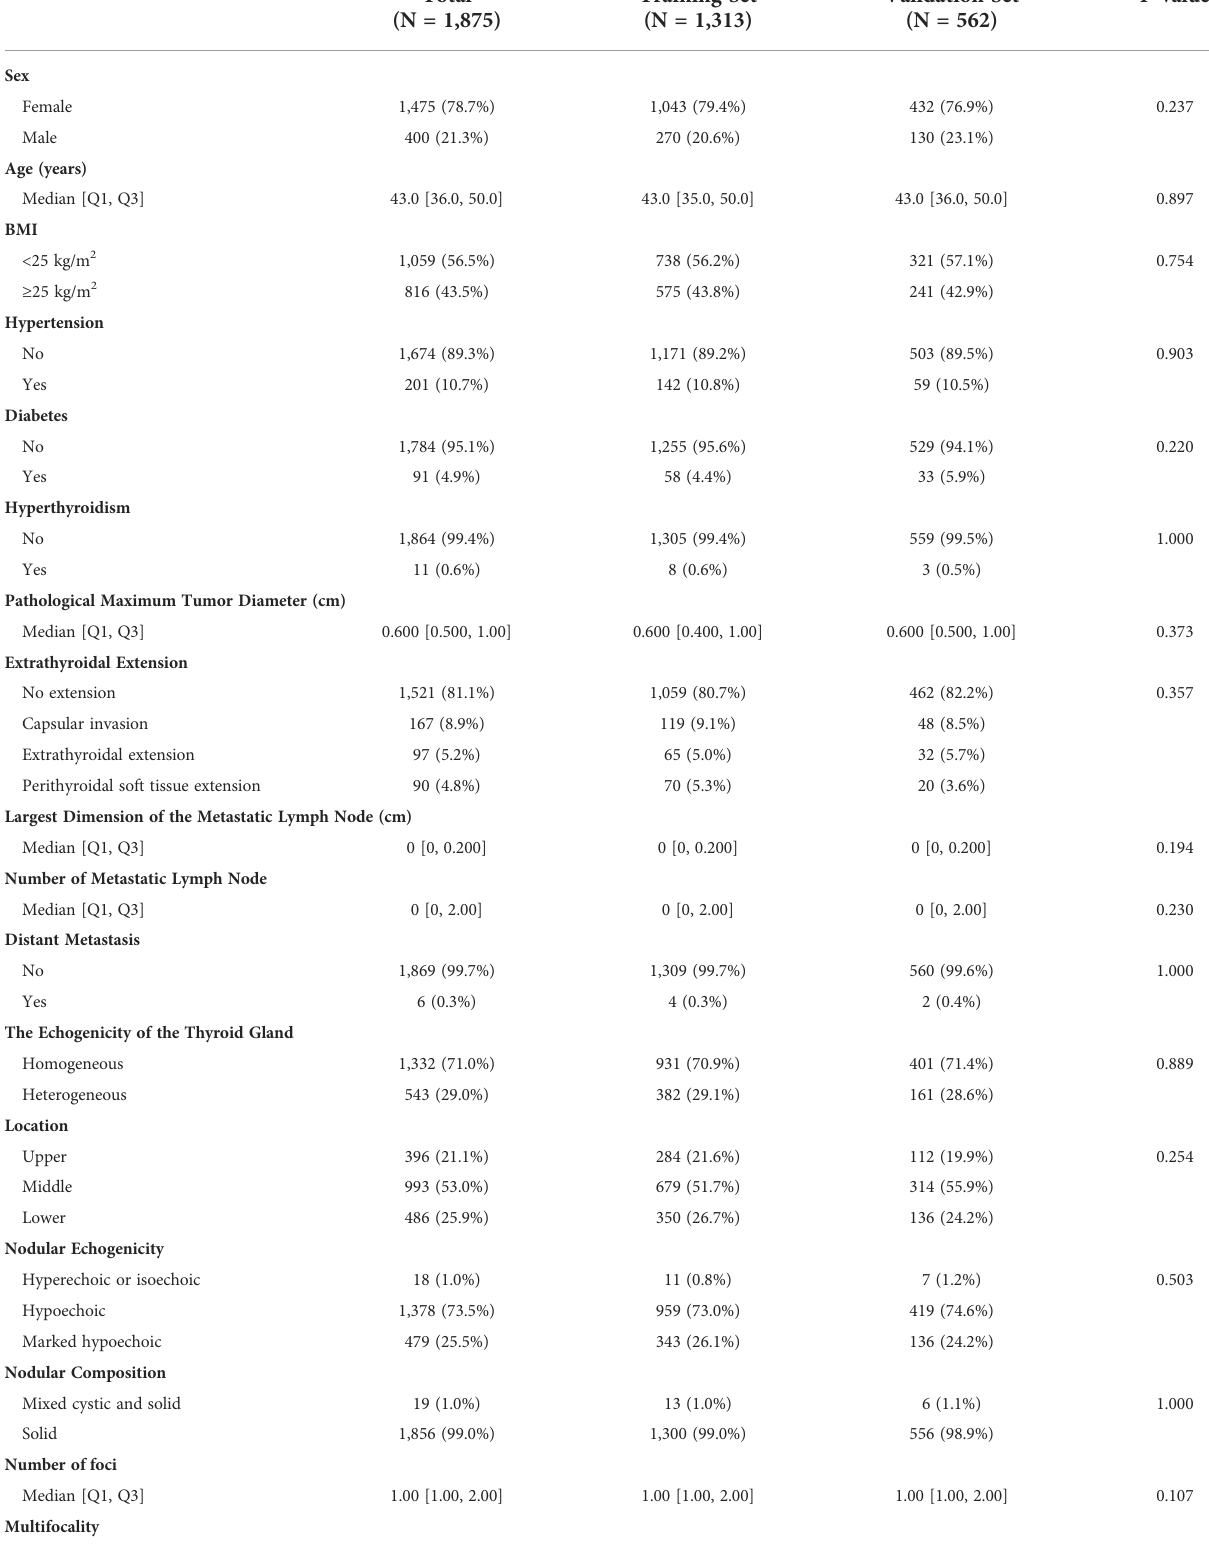
TABLE 2 Baseline clinical characteristics of the enrolled